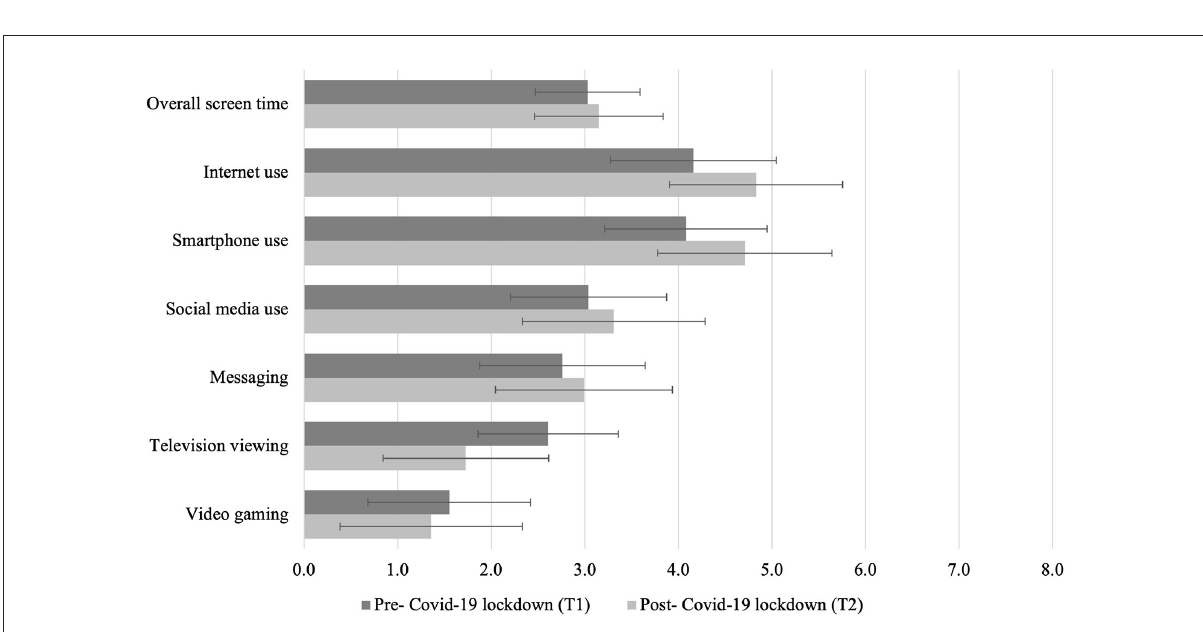
FIGURE2 Daily duration of screen-media activities before and after the COVID-19 lockdown in Switzerland. Means and standard deviations are shown.